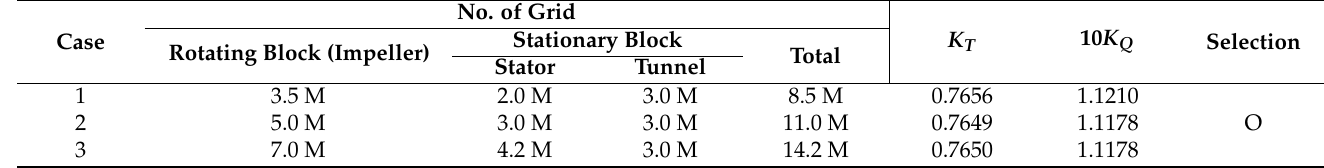
Table 2. Grid dependency test and the results at J = 0.85.